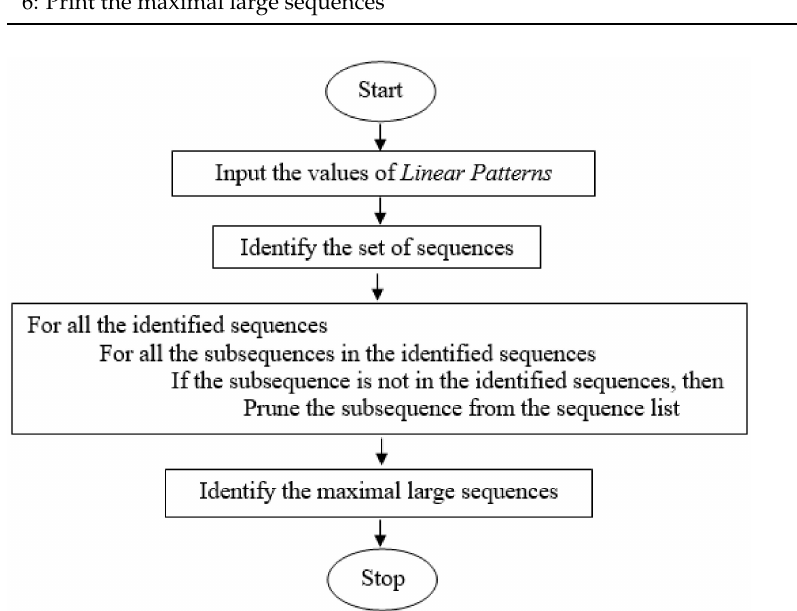
Figure 5. The proposed linear pattern pruning strategy.